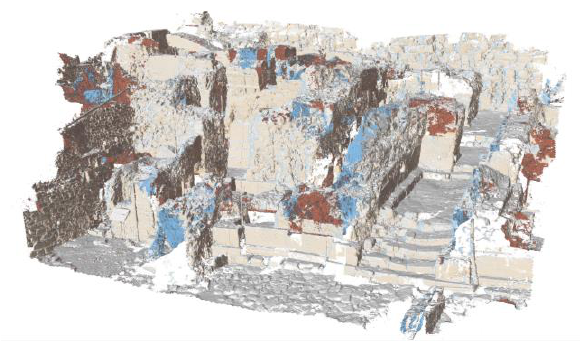
Figure 6. GoPro point cloud (RealityCapture): perspective